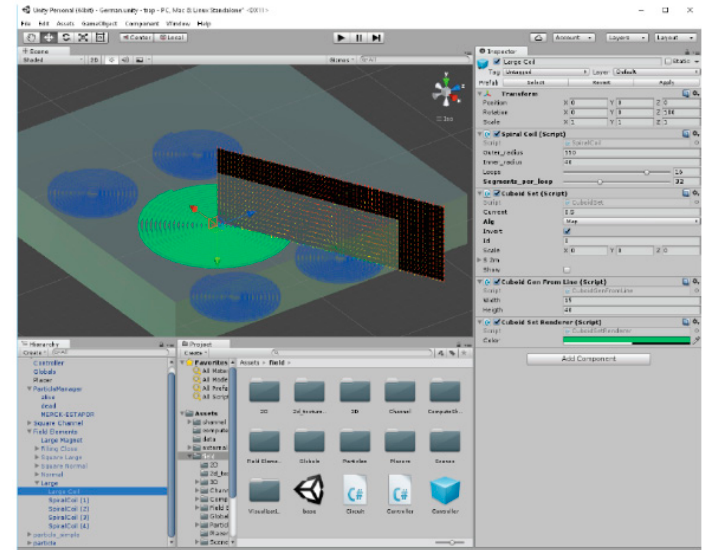
Figure 1. Graphical User Interface of UNITY3D editor (multimedia view).